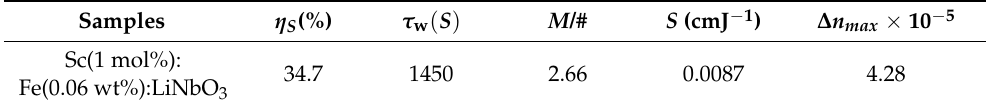
Table 5. The red (633 nm) photorefractive properties of Sc:Fe:LiNbO 3 crystal. Samples η S (%) τ w ( S ) M